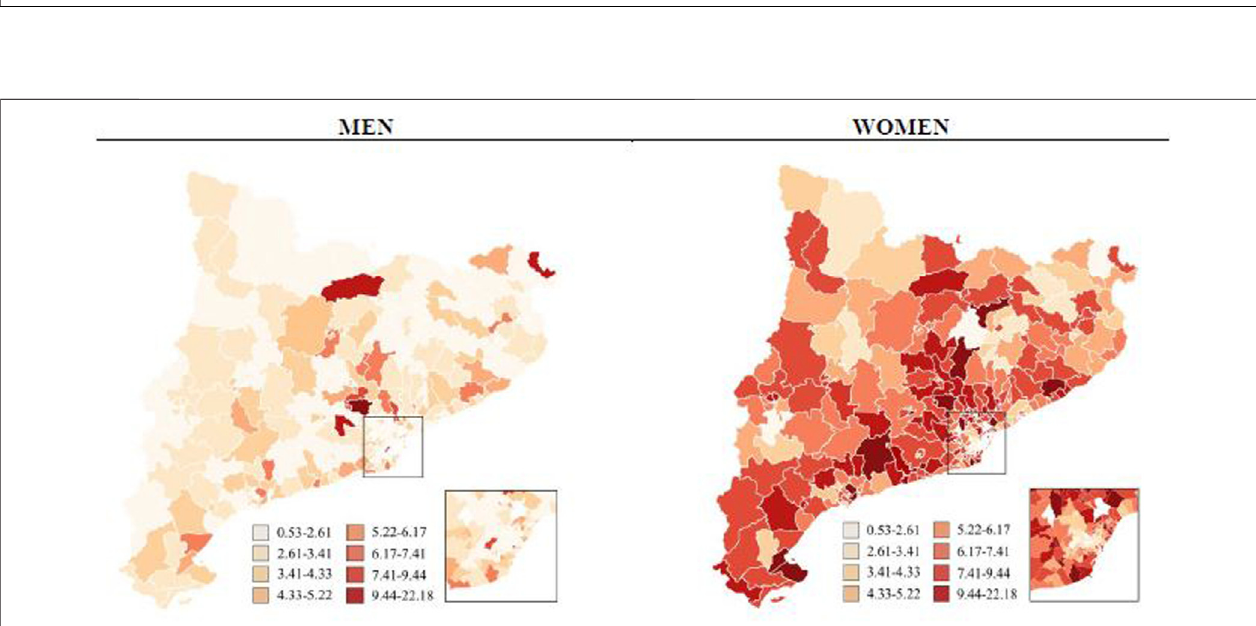
FIGURE 4 | Strong opioids use (DDD/1,000 inhabitants per day standardized by age) by sex and health area in Catalonia, 2019.